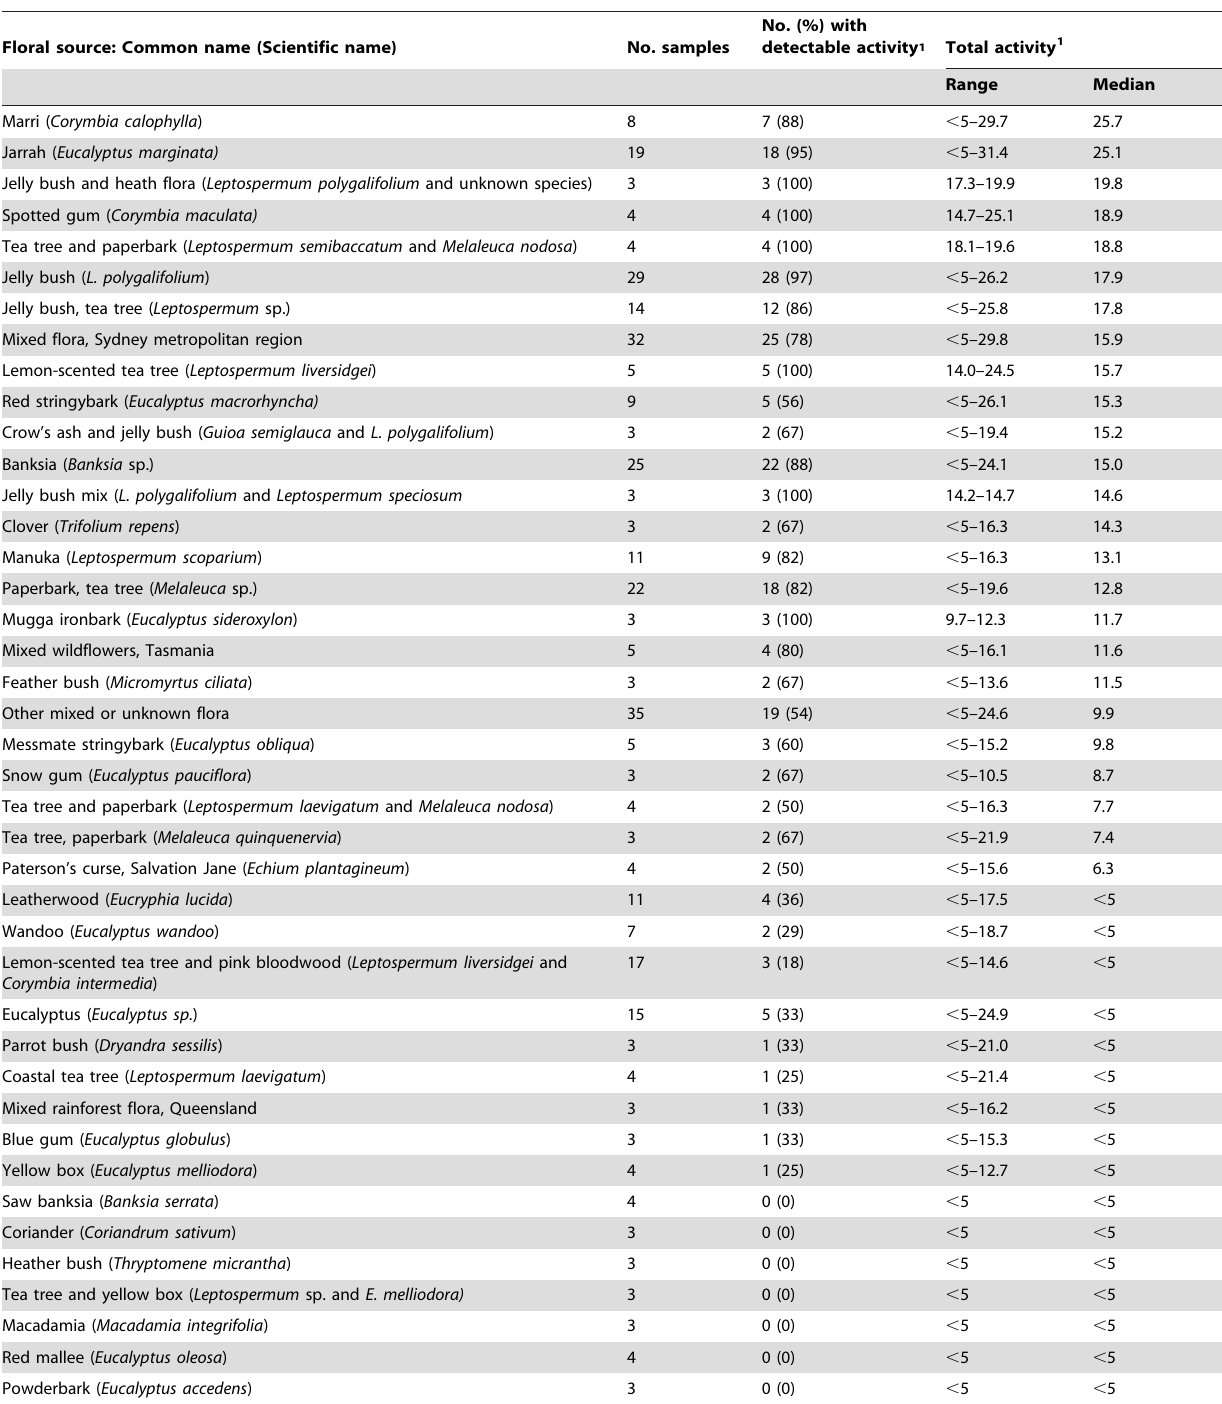
Table 1. Total antibacterial activity of honey samples from floral sources with a sample size $ 3, ranked by median